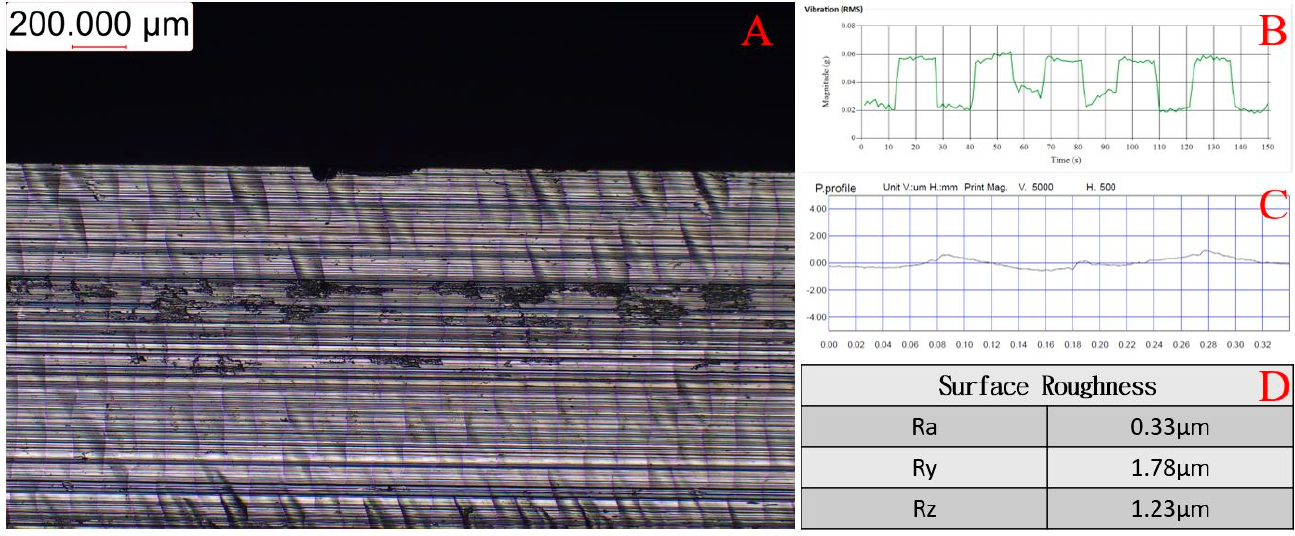
Figure 19. D5-measurement result of Parameter 1.